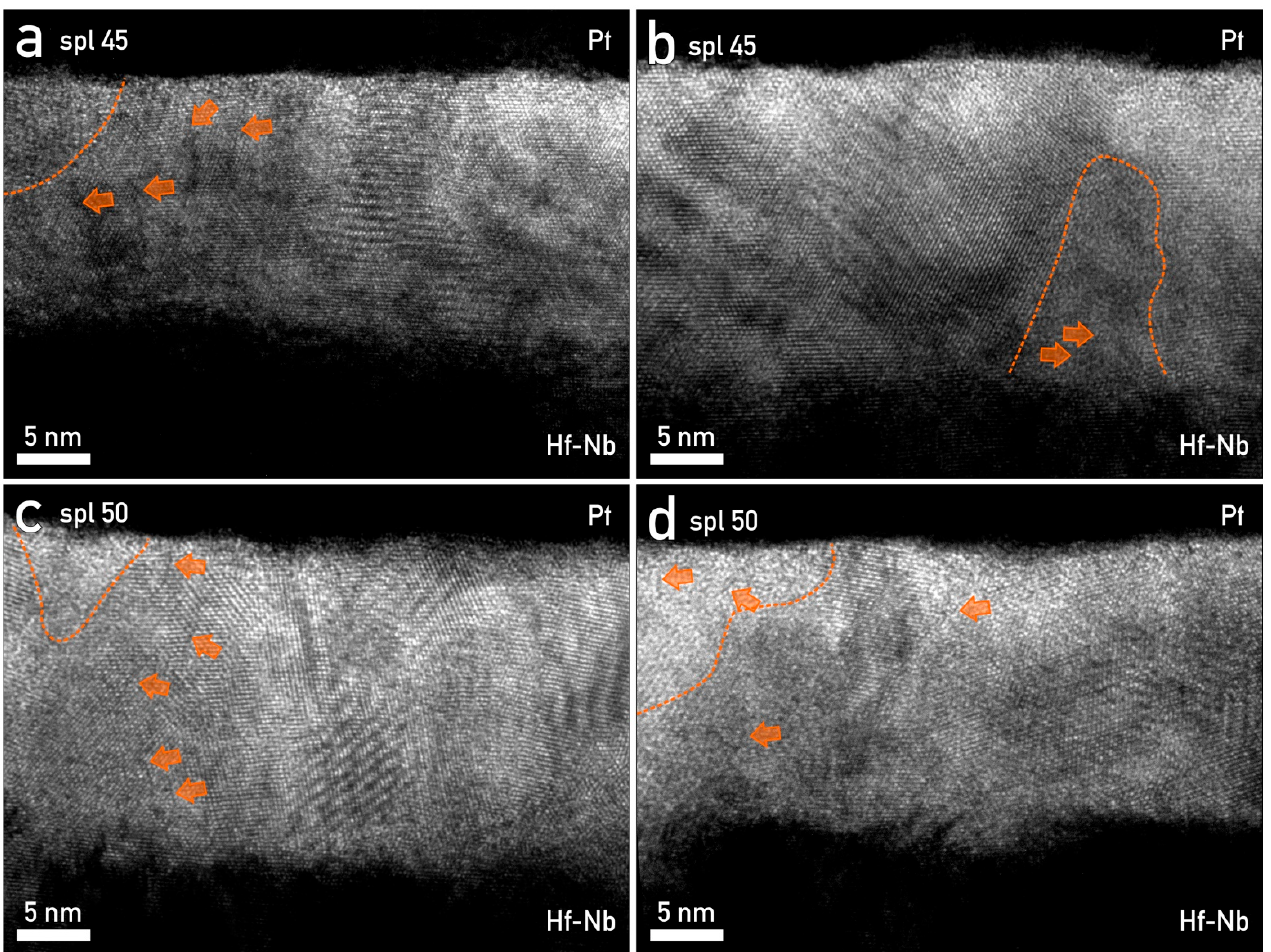
Figure 7. HR-TEM micrographs of Hf–Nb oxide layer. ( a , b ) Sample Hf-45 at.% Nb, ( c , d ) sample Hf-50 at.% Nb. Crystalline HfO 2 was sporadically interrupted by amorphous Nb 2 O 5 regions (outlined with a dashed orange line). The conductive filaments emerging from metal layers are marked by orange arrows.